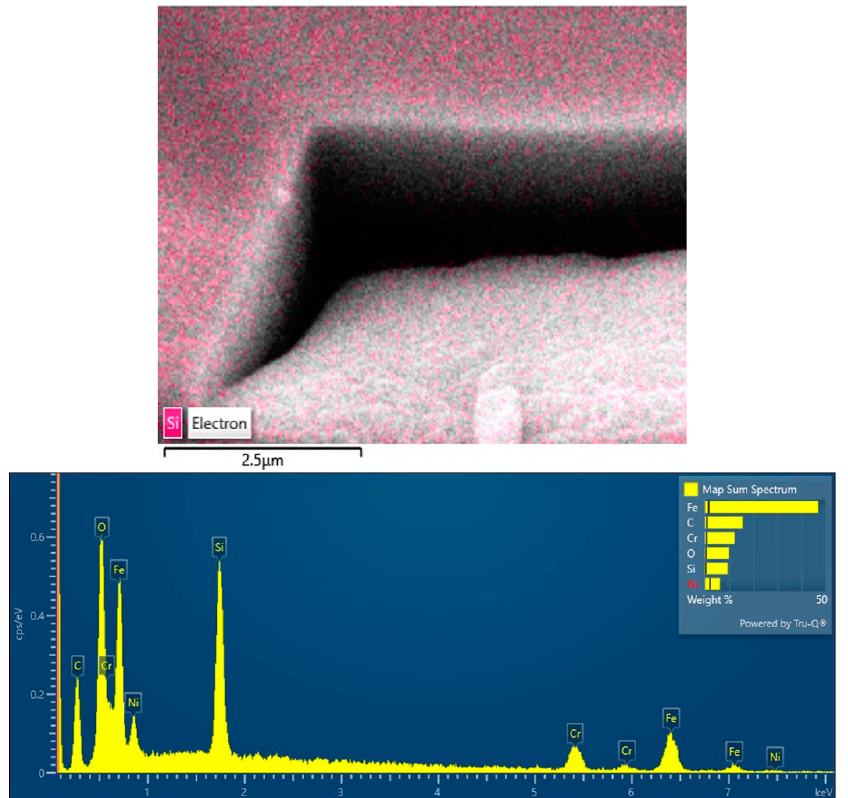
Figure 18. EDX spectra and silicon particle distribution around cross-section obtained by FIB machining of surface textured with parallel lines scanning strategy at 12 W: Surf 4 sample (laser texturing + PE-CVD).